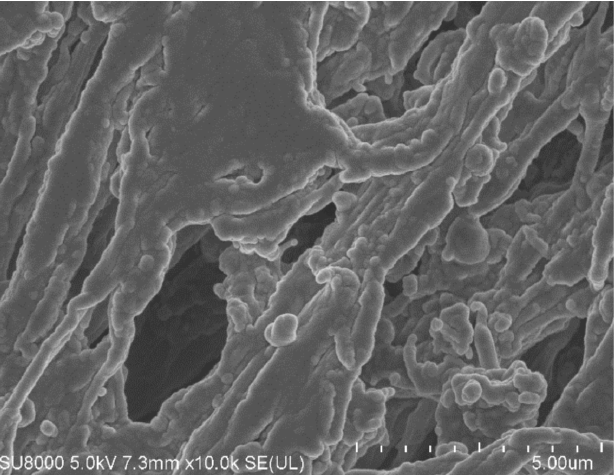
Figure 22. SEM images of membrane surface after module M7 rinsing with 3% HCl